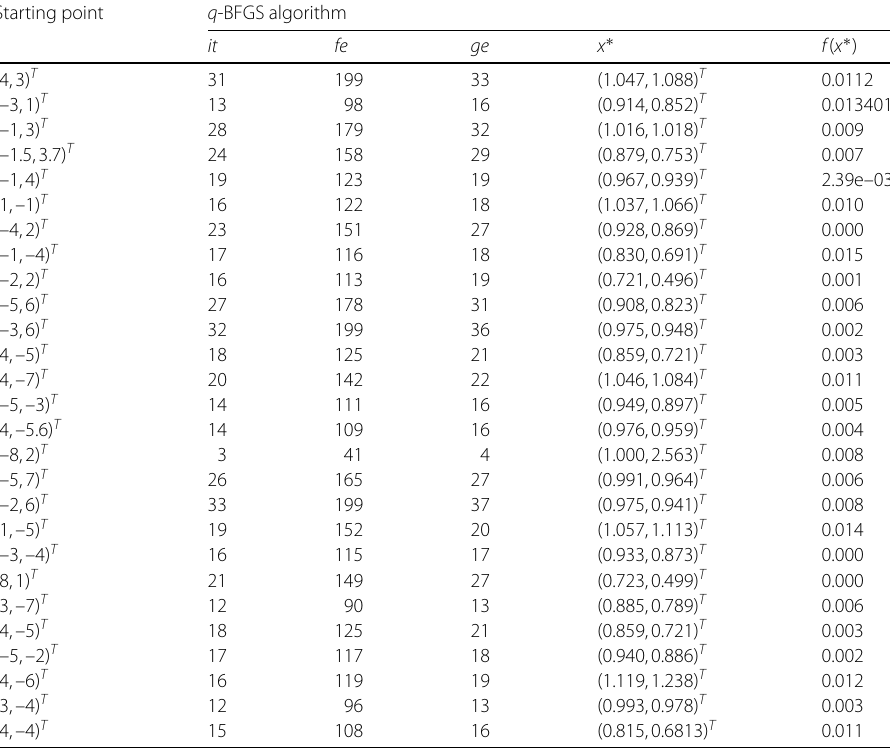
Table 3 Numerical results of Example